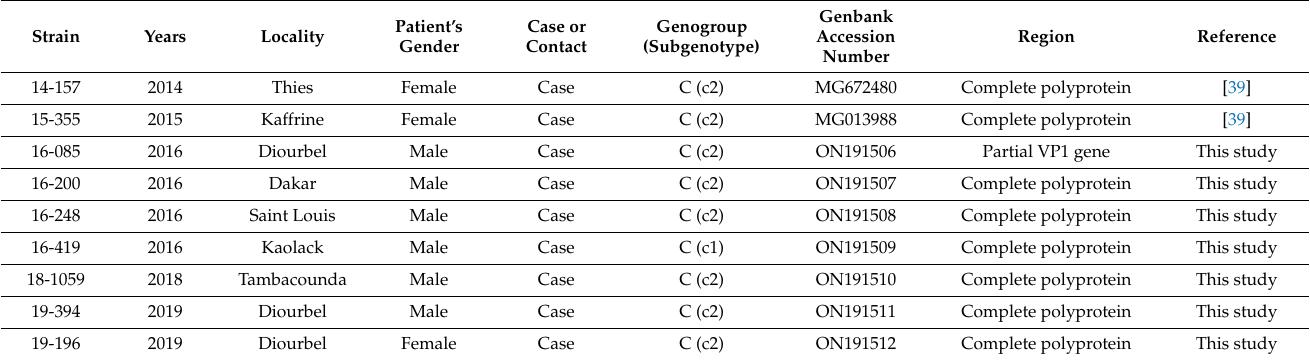
Table 2. Description of the newly characterized sequences of